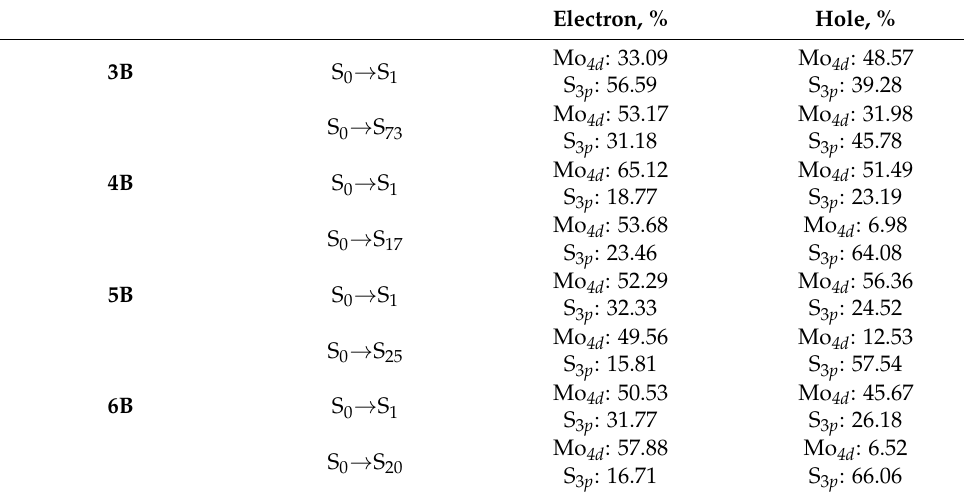
Table 5. S 0 → S 1 transition, S 0 → S n transition, and the percentage of Mo 4 d and S 3 p in electron and hole of 3B , 4B , 5B , and 6B